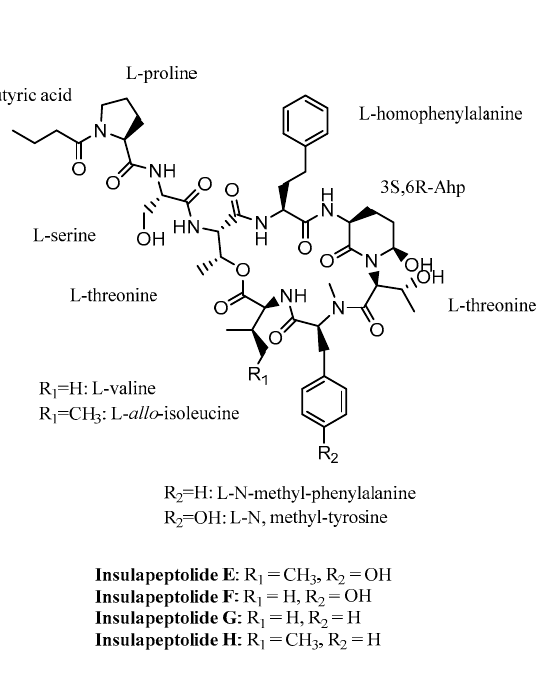
Figure 8. Structures of Insulapeptolides A–H.